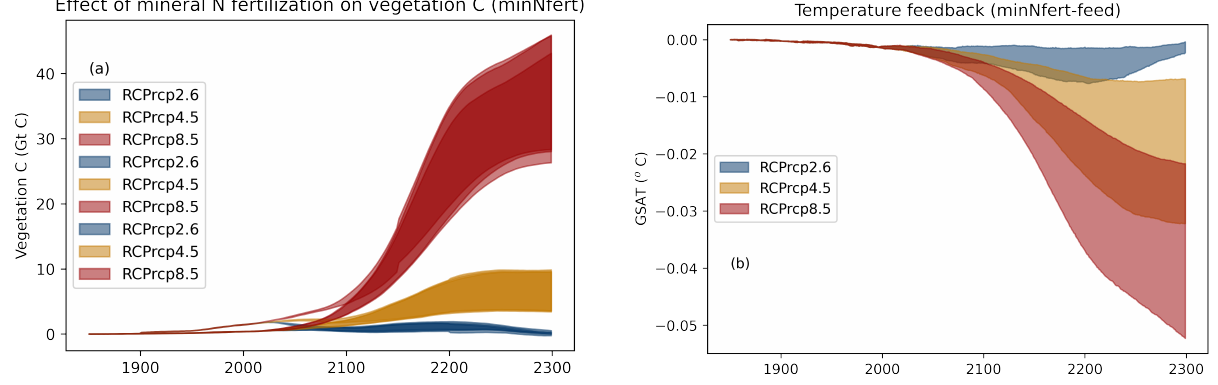
Figure 8. ( a ) The time series of the extra vegetation C uptake after fertilisation by mineral N released from thawing permafrost (minNfert). ( b ) The time series of the global surface air temperature (GSAT) response caused by the mineral nitrogen vegetation fertilisation feedback (minNfert-feed). See Table 2 for more details on how these are